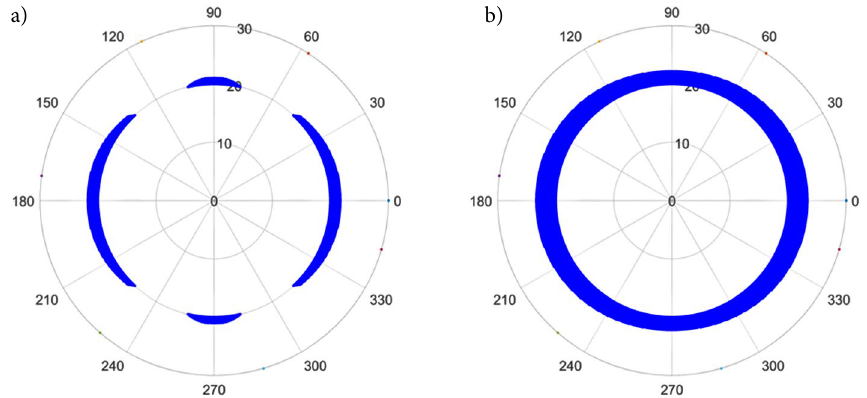
Figure 12. Failure contour for the normal faulting stress regime: a) a = 0°, i = 0°; b) a = 90°, i = 90°